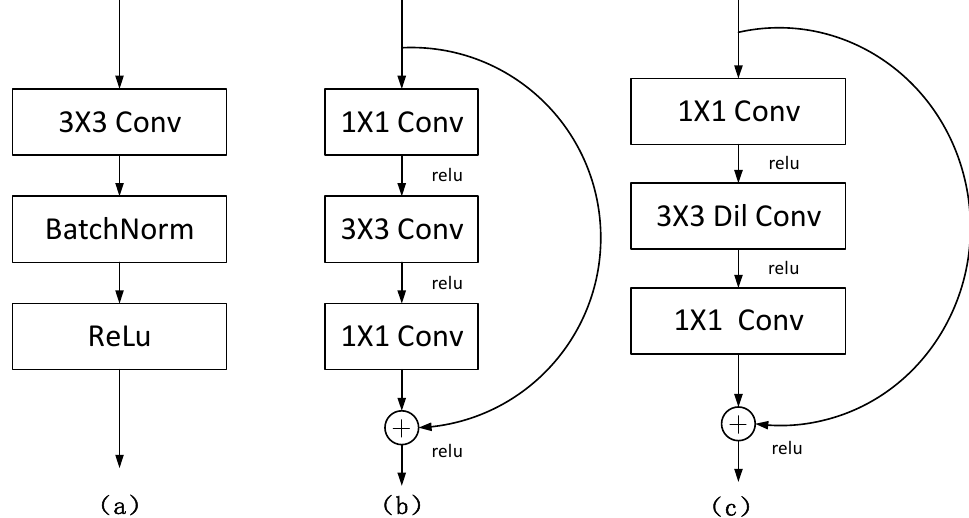
Figure 4. ( a ) The structure of convolution block; ( b ) the original structure of Bottleneck; ( c ) the structure of Bottleneck replaced with dilated convolution.